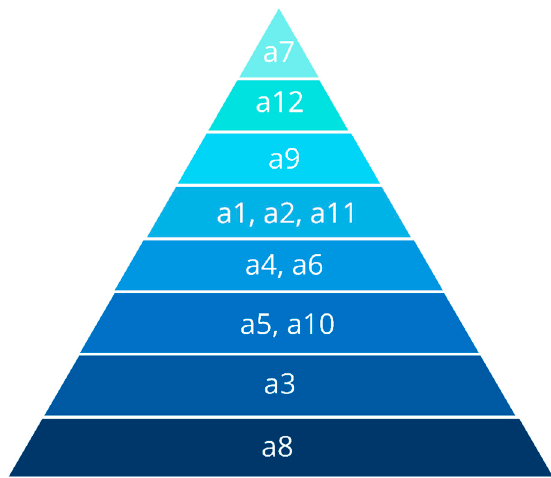
Figure 3. Final ranking—graphic visualization.